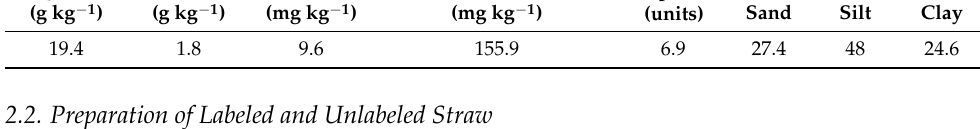
Table 1. Selected physicochemical properties of the chernozem soil studied. Organic